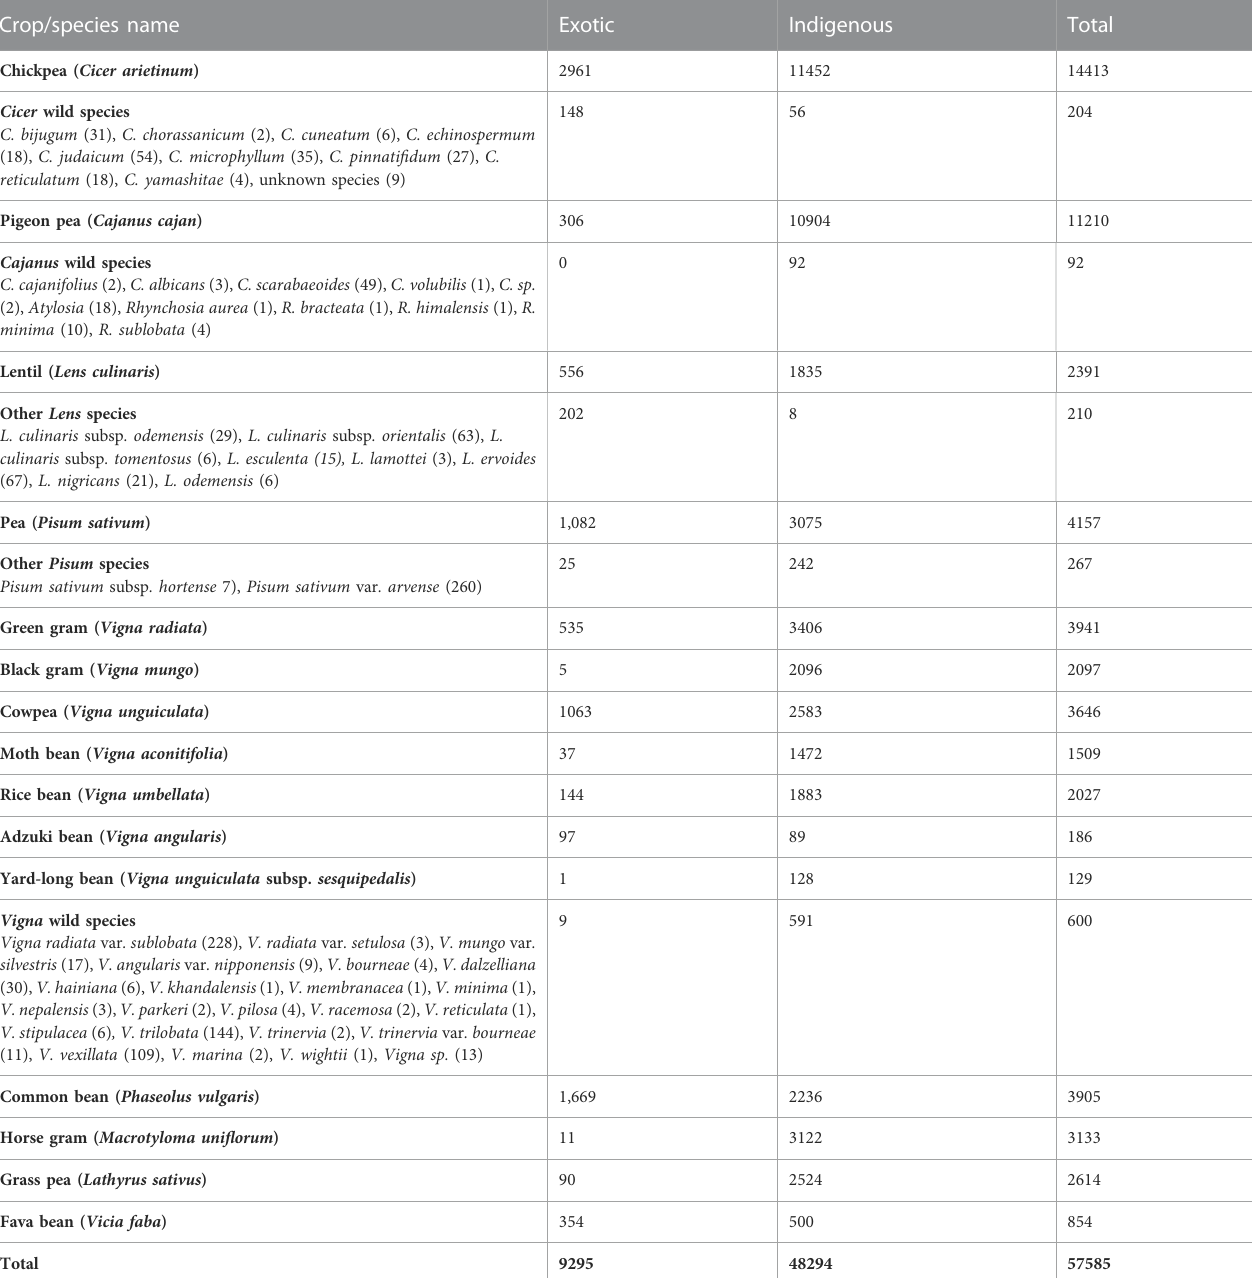
TABLE 2 Status of collections of grain legume crops and their wild relatives available in the Indian National Gene Bank. Crop/species